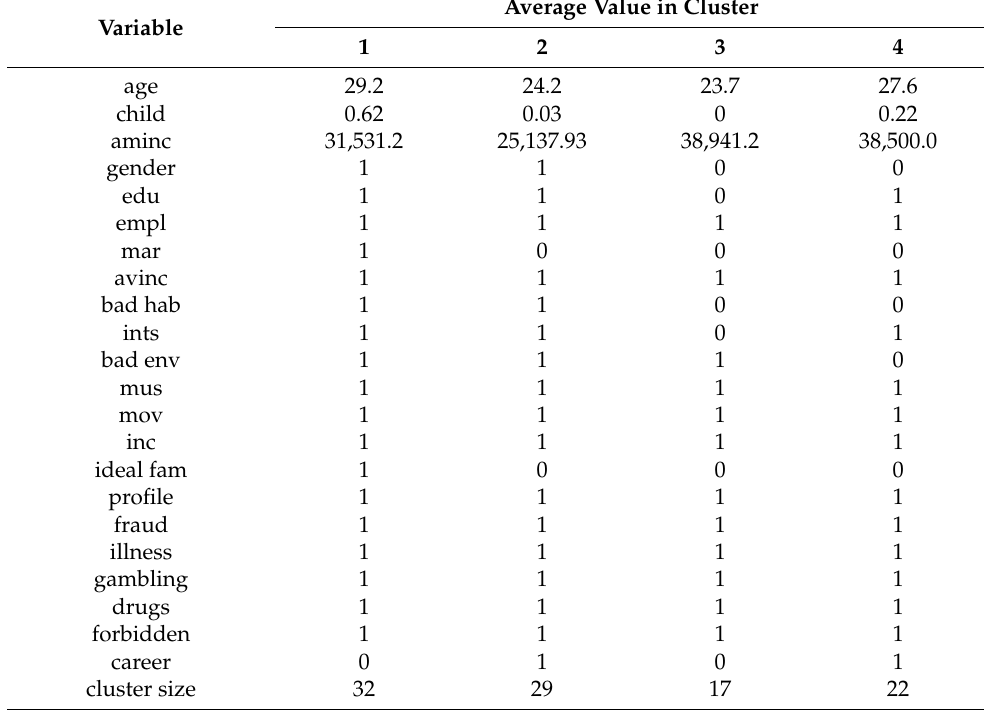
Table 5. Cluster centers.